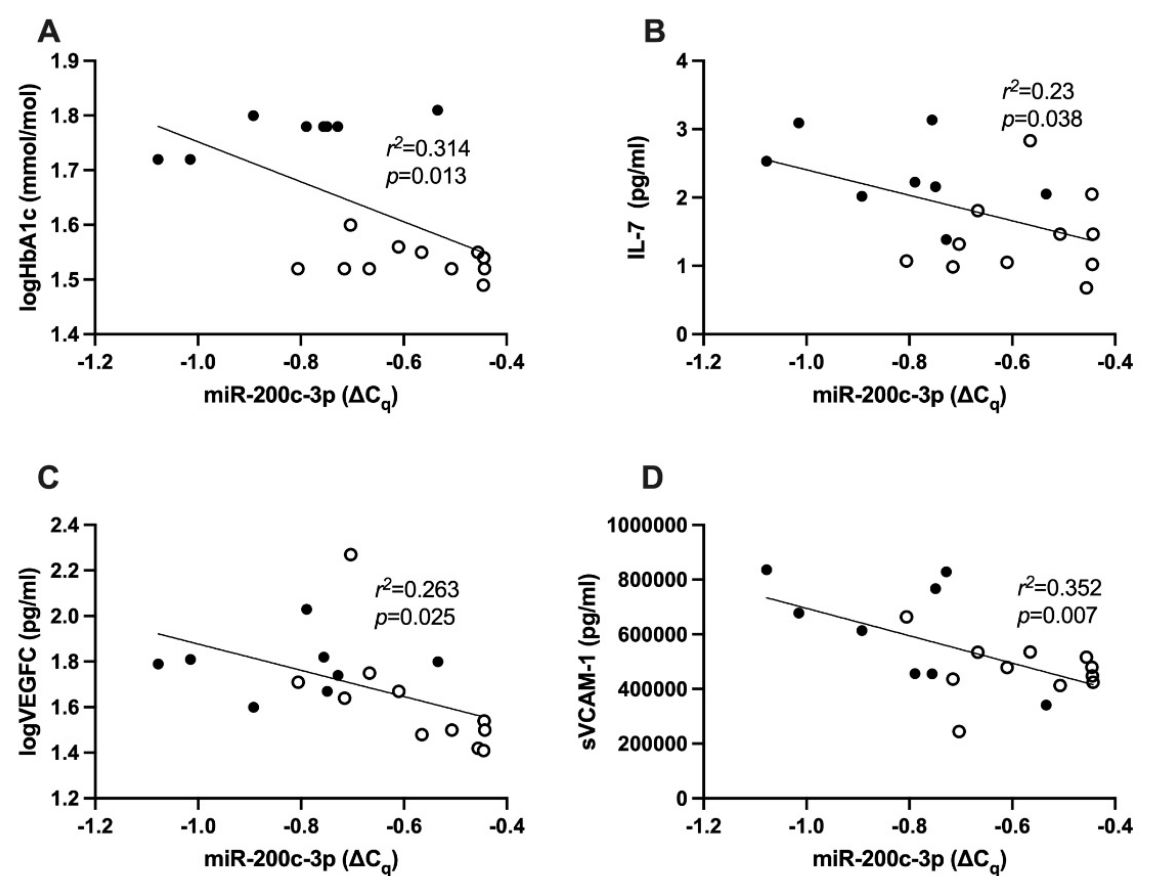
Figure 2. ( A ) Correlation between miR-200c-3p in PBMCs and HbA1c (r 2 = 0.314, p = 0.013) as a parameter to portray the glycemic control across study groups, ( B ) correlation between miR-200c- 3p in PMBC and IL7 (r 2 = 0.23 p = 0.038), ( C ) logVEGFC (r 2 = 0.263, p = 0.025), ( D ) sVCAM-1 (r 2 = 0.352, p = 0.007), across study groups in the plasma. Statistical analysis was carried out using linear regression analysis. IL: interleukin; VEGFC: vascular endothelial growth factor C; sVCAM-1: circulating vascular cell adhesion molecule 1.